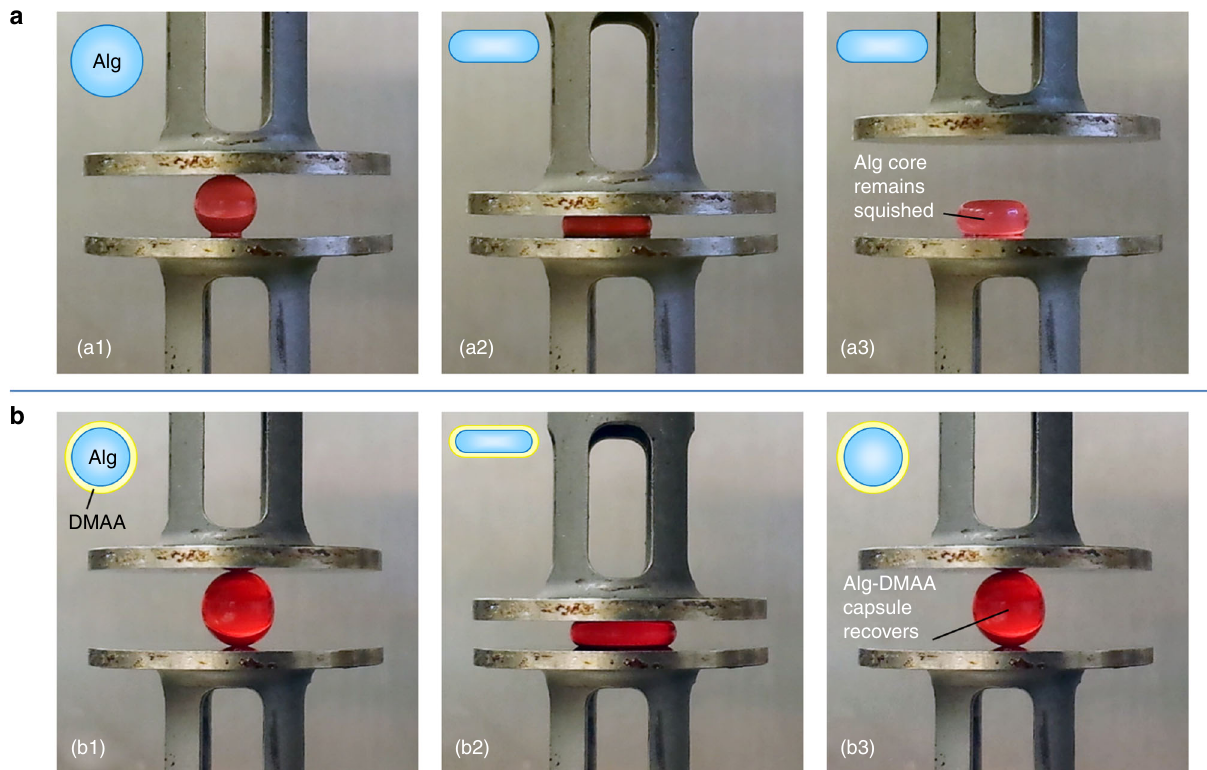
Fig. 4 Contrasting mechanical properties of a core gel particle versus a single-layer capsule. Photos are shown of an Alg gel particle ( a ) and an Alg – DMAA capsule ( b ) being compressed between parallel plates. Both have the same core diameter of 4.6 mm, with the DMAA shell being 200 µ m thick. Photos a1 to a3: when the Alg gel is compressed by 50%, it remains squished and does not recover when the compression is removed (plastic response). This is indicated by the schematics and also demonstrated by Supplementary Movie 1. Photos b1 to b3: when the Alg – DMAA capsule is compressed by 60%, it recovers as soon as the compression is removed (elastic response). Thus, the addition of the thin DMAA shell (1/20th the thickness of the core) dramatically alters the mechanical properties. This behavior is indicated by the schematics and also shown by Supplementary Movie 2, which further shows that the elastic behavior is preserved over multiple cycles of